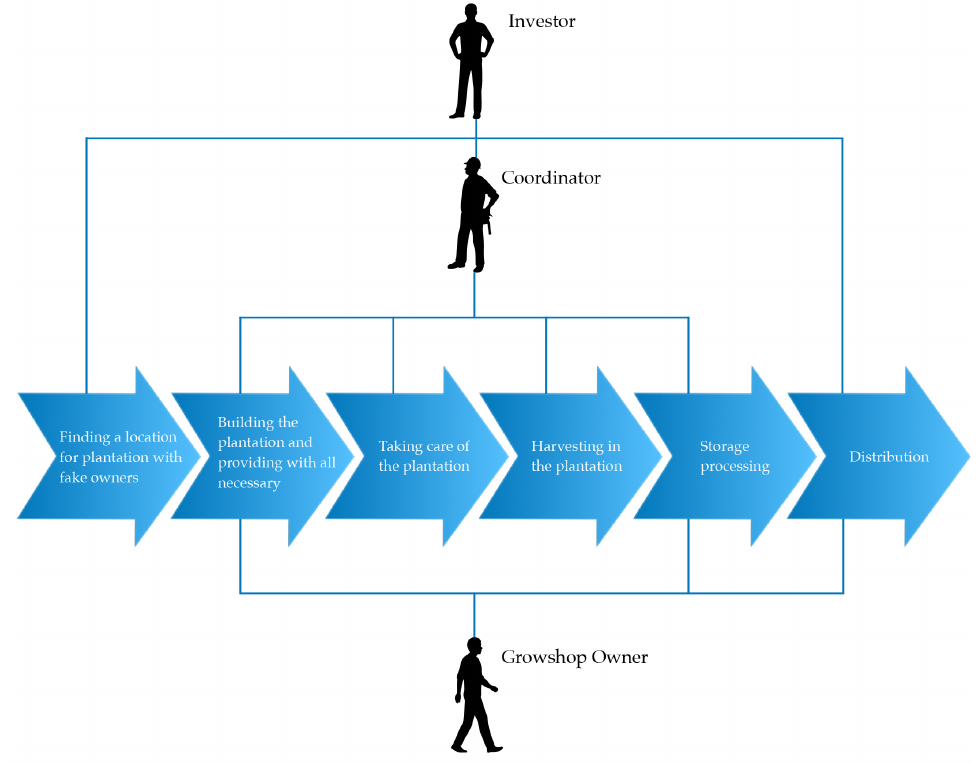
Figure 3. Crime script of cannabis